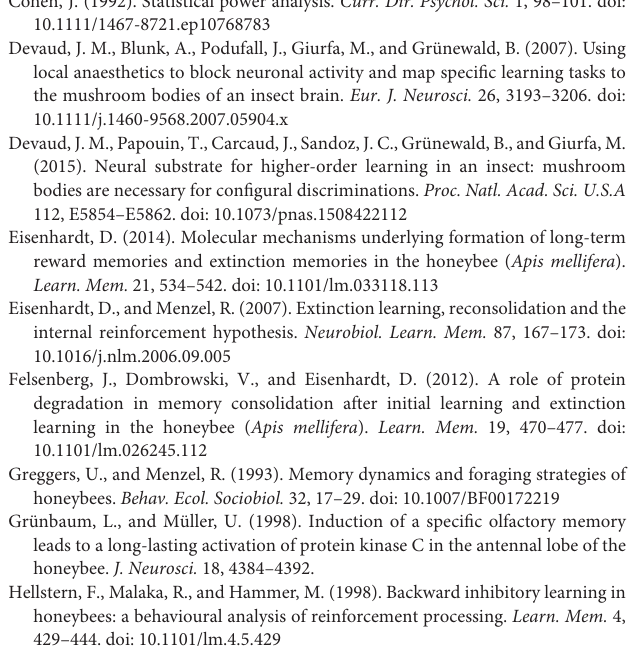
TABLE S1 | Summary of all Dnmt inhibition studies to date. The table includes the following information: experimental IDs and the training paradigm used. The Dnmt inhibitor (Inhib.) used which was either zebularine or RG108 and the solvent DMF as control. In all cases the inhibitor was applied topically onto the thorax except if an “i” behind the inhibitor’s name indicates it was injected into the thorax. Odors were either vanilla in sugar water (Vsu), limonin in salt water (Lsa), 1-hexanol (HexL), 1-nonanol (NonL), 1-hexanone (HexN) or 1-heptanone (1-HepN). Test and treatment timepoints are stated in hours relative to the training. The number of bees (NoB) in each group is indicated and the number of bees responding correctly (RR) or wrongly (WR) as defined in Table 1 . The percent of bees responding correctly is indicated C.R. (%). Furthermore the reference (Ref) is given for each previously published dataset: 1 – Lockett et al., 2010, 2 –